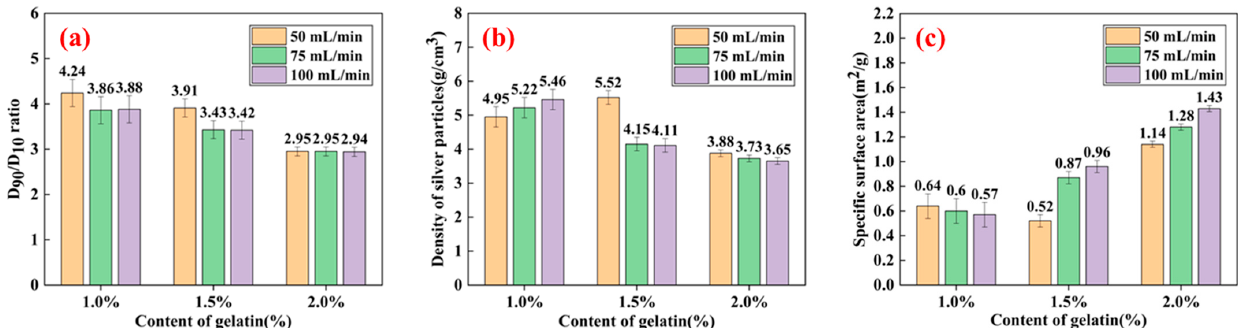
Figure 11. A schematic diagram of the growth process of spherical and dendritic micron silver particles. Figure 12 demonstrates the connection between the added gelatin amount and the D 90 /D 10 ratio, tap density, and specific surface area of the manufactured silver powder particles.